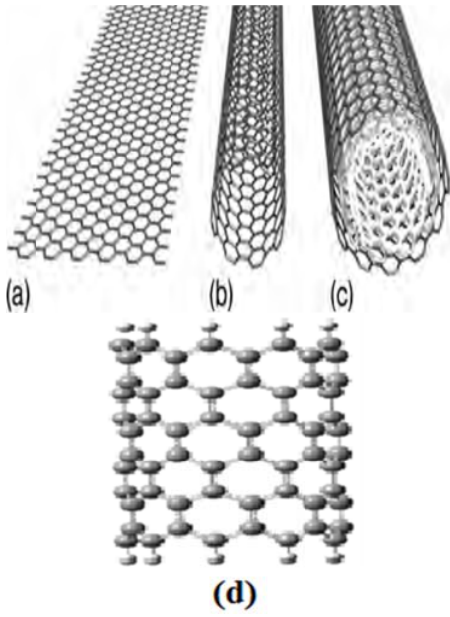
single graph alled carbo walled in (c